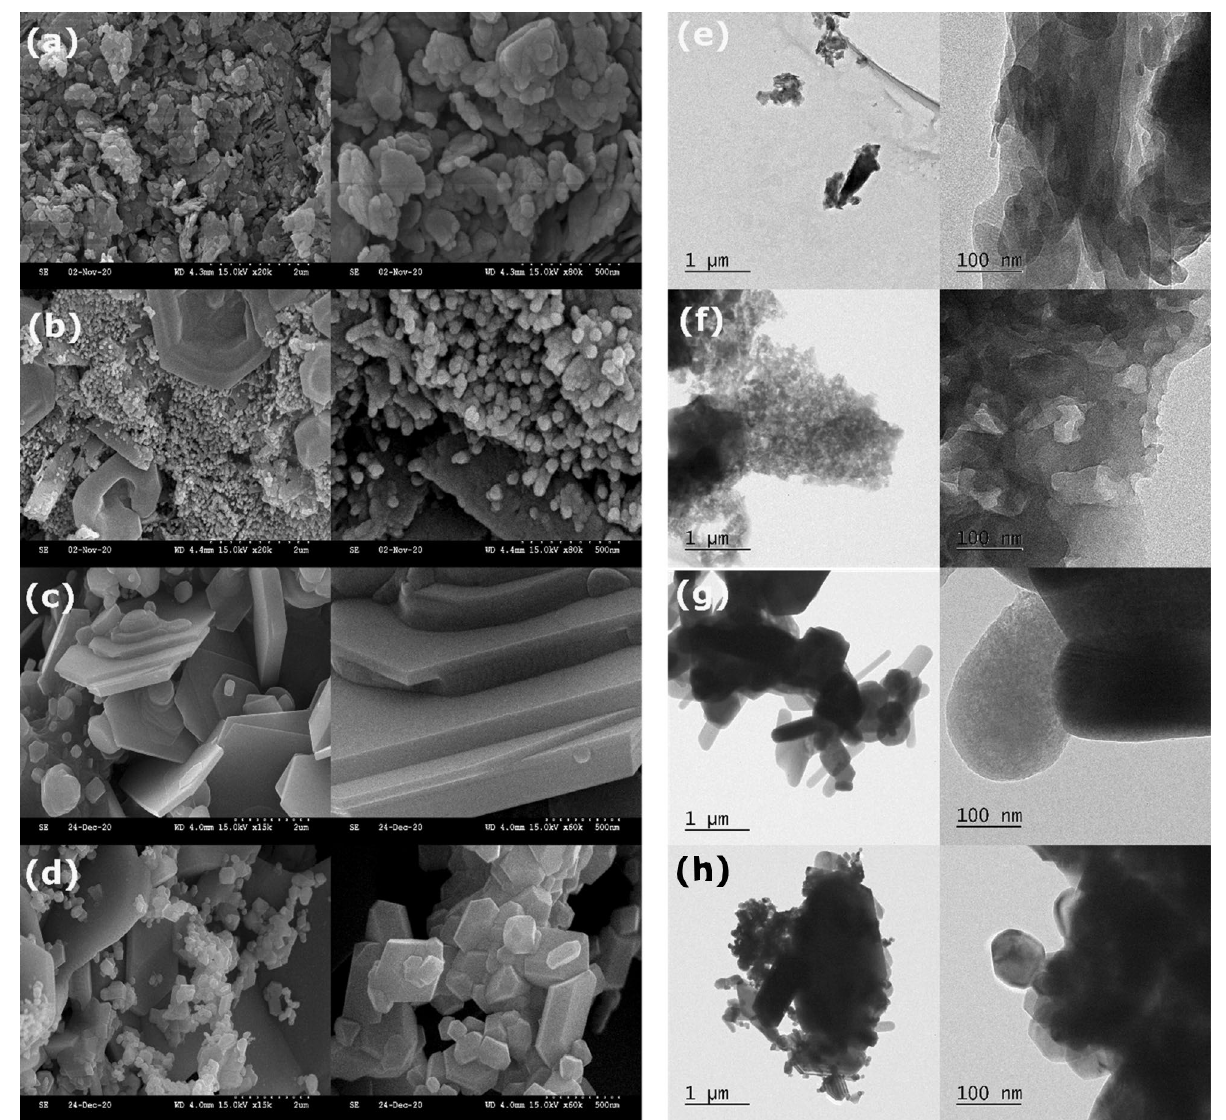
Figure 1. SEM images of (a) CoBDC; ( b ) CoBTC; ( c ) NCO-D; ( d ) NCO-T; TEM images of ( e ) CoBDC; ( f ) CoBTC; ( g ) NCO-D; ( h )